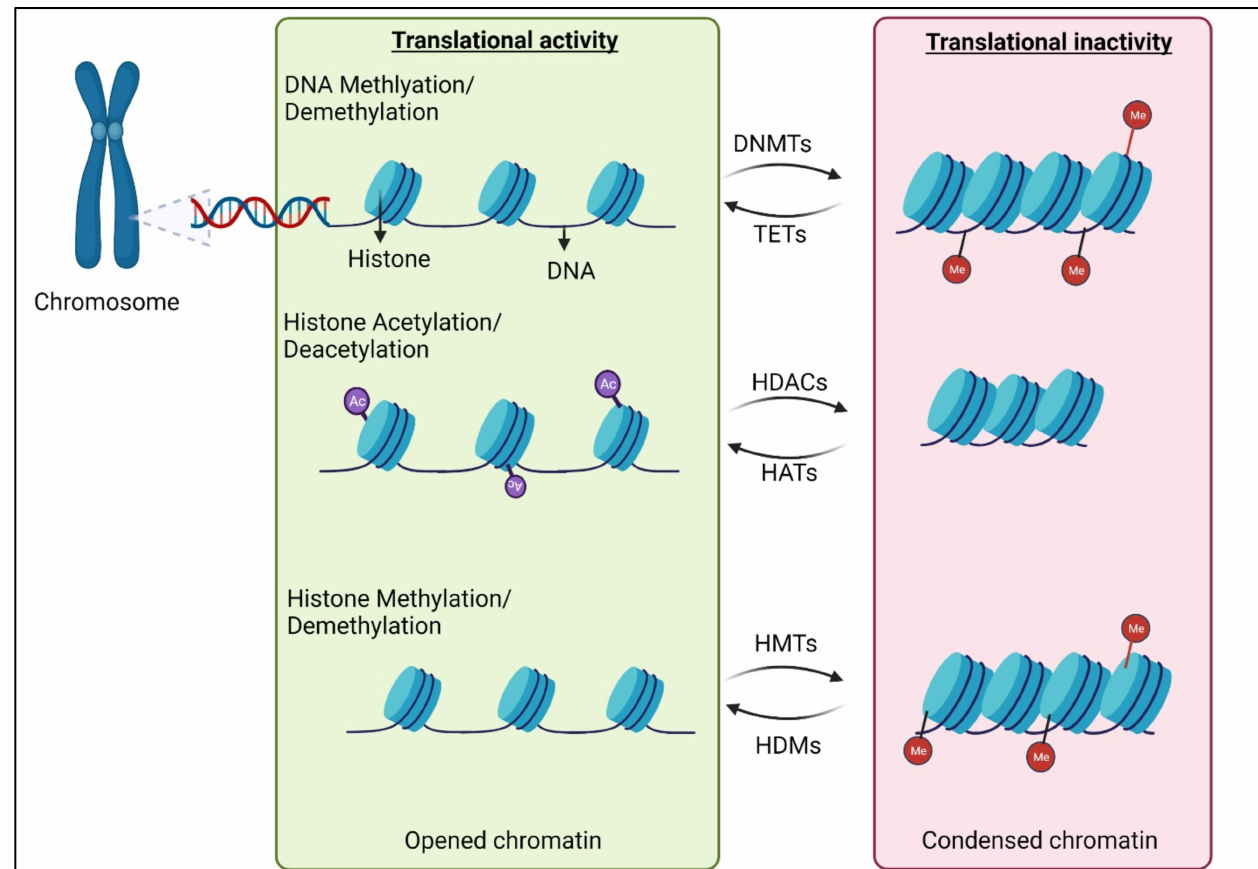
Figure 1. Epigenetic regulation of gene expression. Enhanced translational activity occurs after chromatin structure attains an open configuration, generally following DNA and histone demethyla- tion and histone acetylation. This dynamic epigenetic mechanism is fueled by a group of enzymes that are categorized by their characteristic of presenting or reverting the methyl and acetyl groups on the histone or DNA structure. DNMT: DNA methyltransferase; TET: Ten-eleven